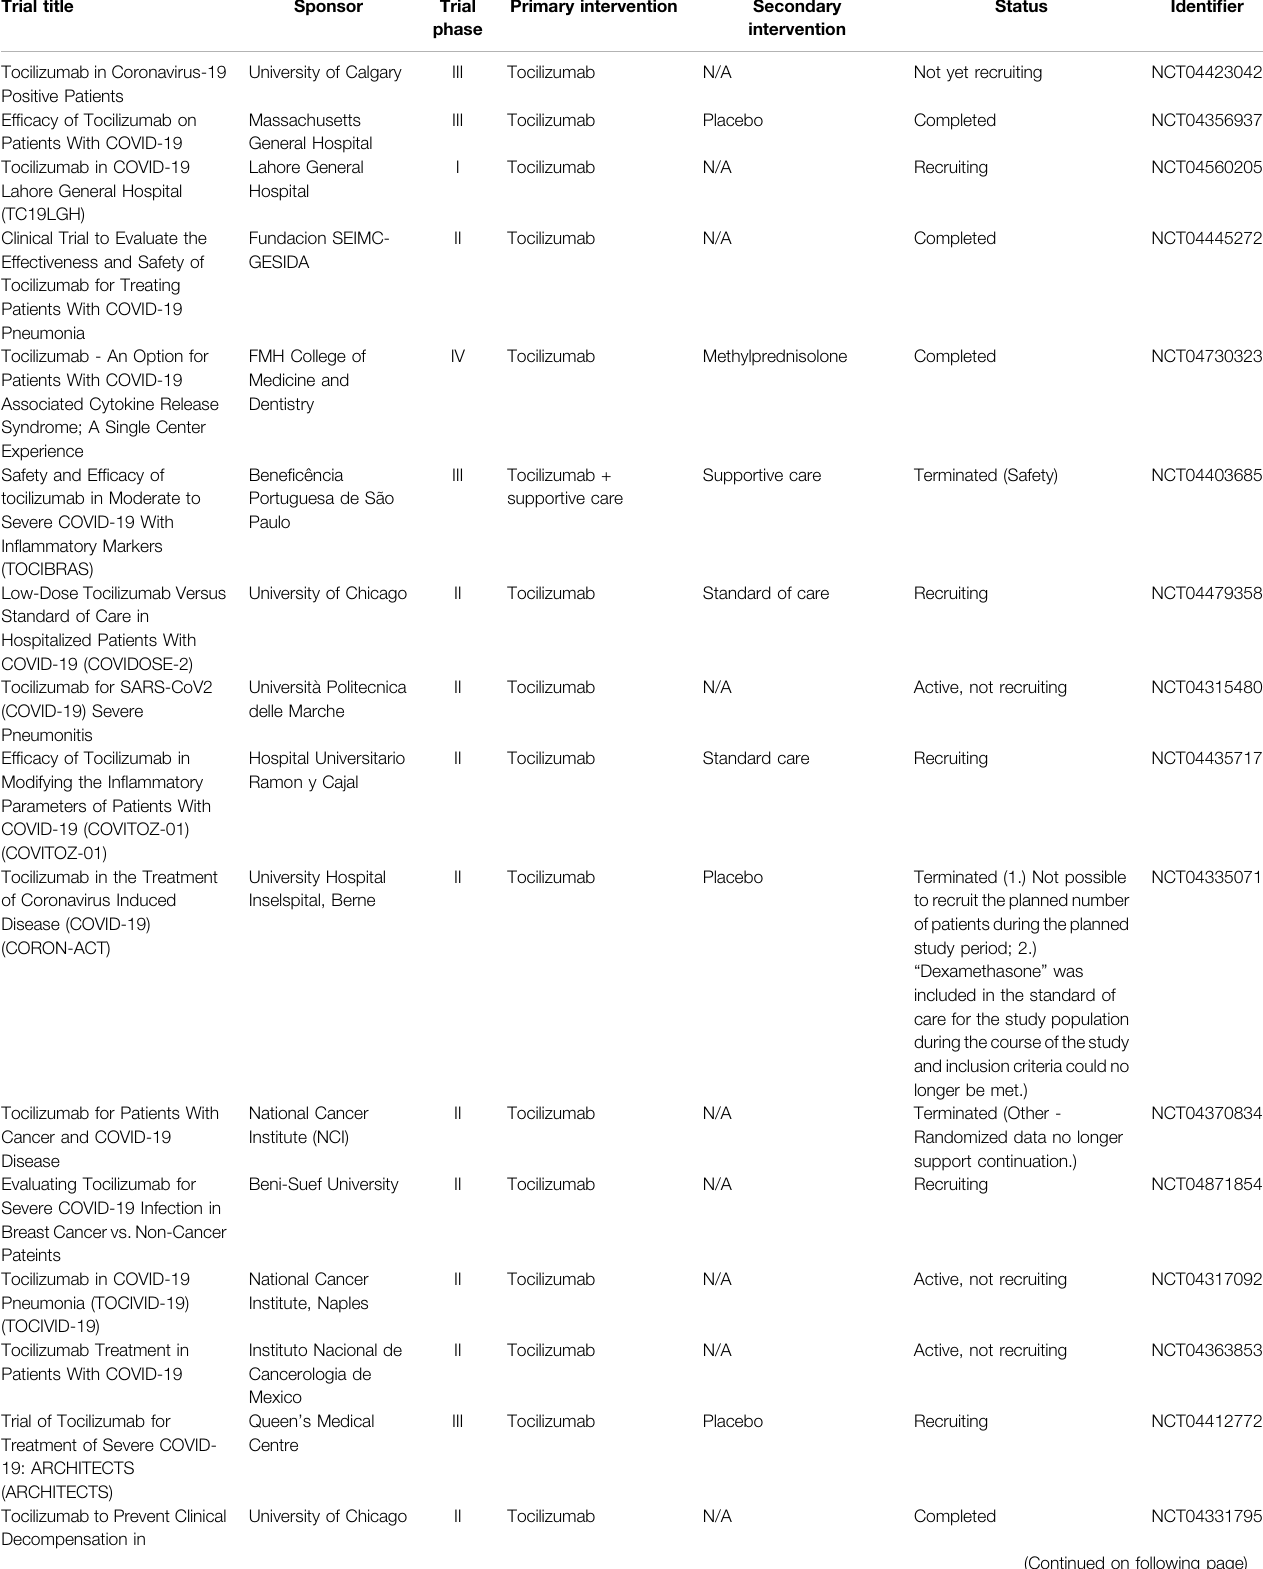
TABLE 7 | Summary of clinical trials of tocilizumab (TCZ) on COVID-19